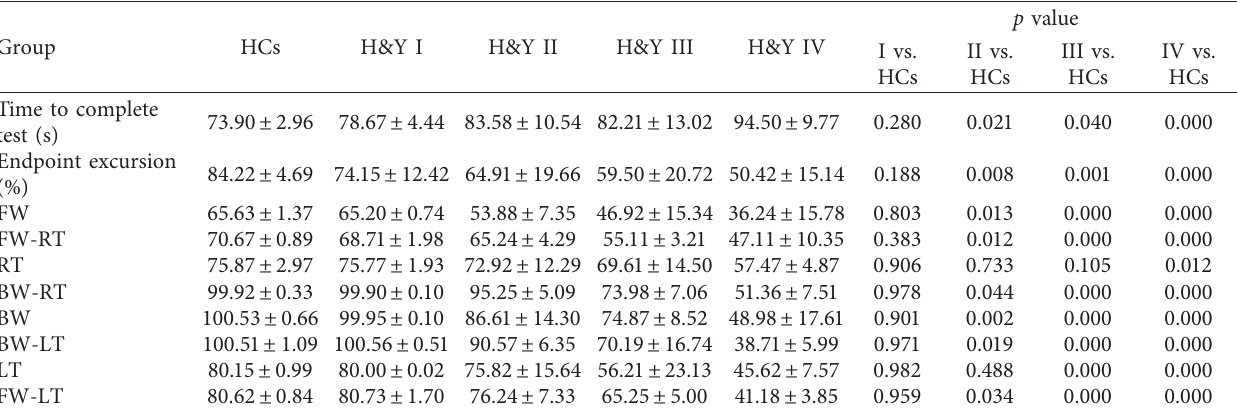
Table 2: Limit of stability